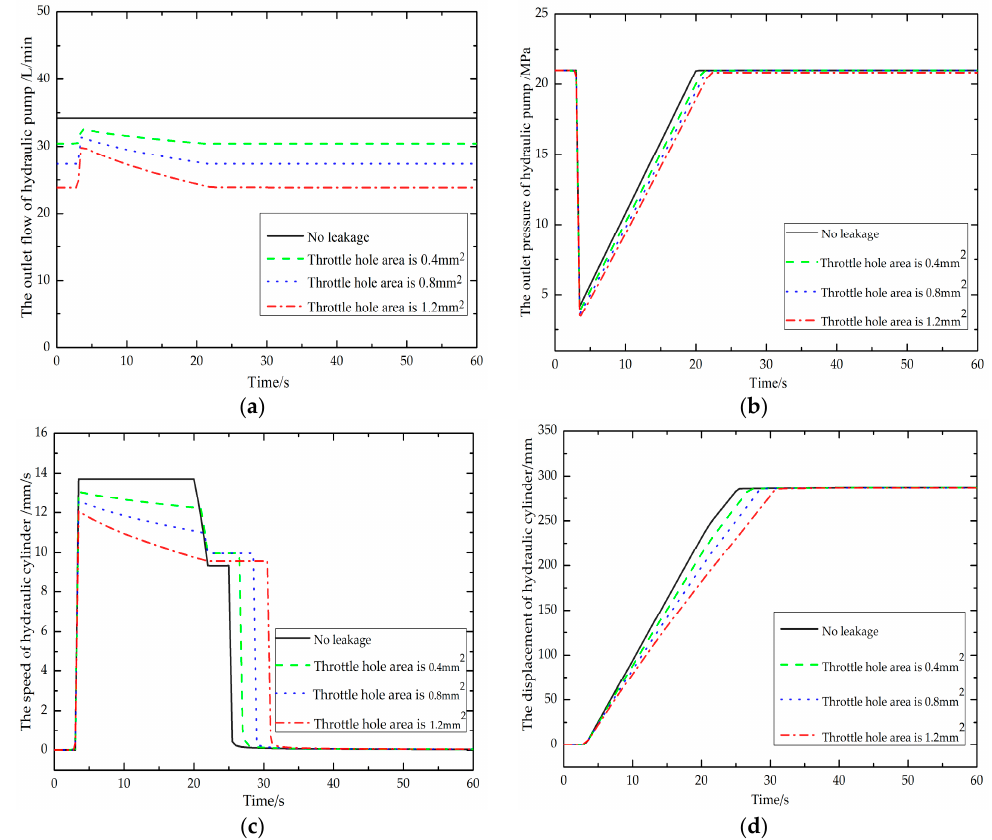
Figure 6. When the internal leakage occurred in the hydraulic pump. ( a ) The outlet flow of the hy- draulic pump; ( b ) the outlet pressure of the hydraulic pump; ( c ) the speed of the hydraulic cylinder; ( d ) the displacement of the hydraulic cylinder.